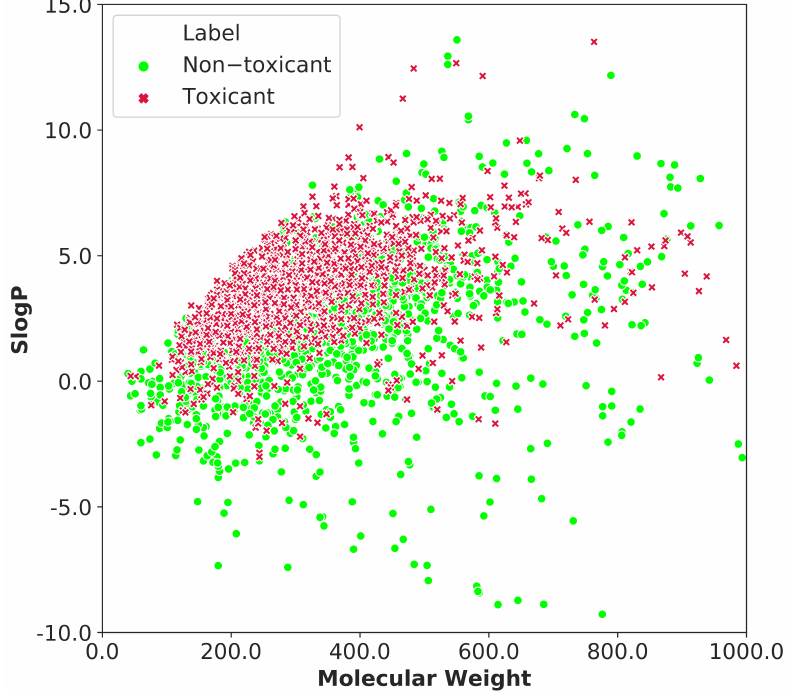
Figure 4. The chemical-space distribution of the whole dataset is defined by molecular weight and SLogP. The toxic substances are shown by red x markers, whereas the non-toxic compounds are represented by green circle markers.